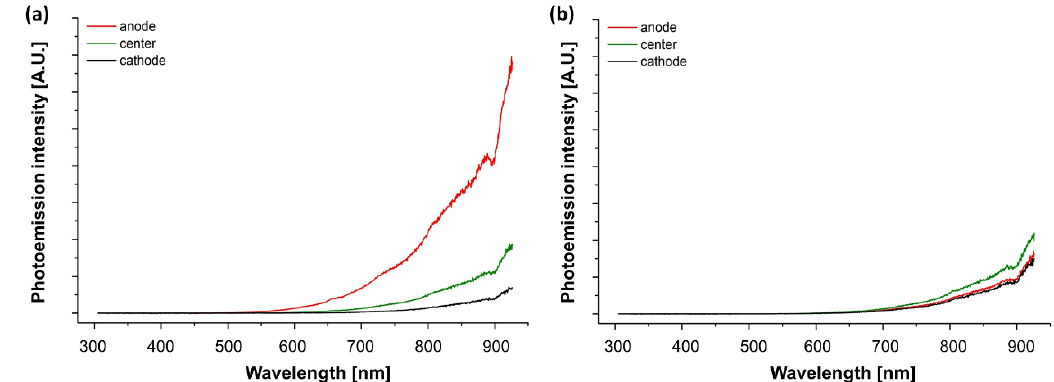
Figure 3. Photoemission spectra recorded in DC (ΔV lim = 50 V, I lim = 165 mA) FS experimental conditions when the current limit was reached. The spectra were recorded at three different points along the sample using ( a ) “bad contact” and ( b ) “good contact” connections. The experiments were carried out in an air using polycrystalline samples (cross section ≈ 2.7 mm 2 , gauge length ≈ 4 mm). The features at ≈ 655 and 890 nm correspond to instrumental artefacts.